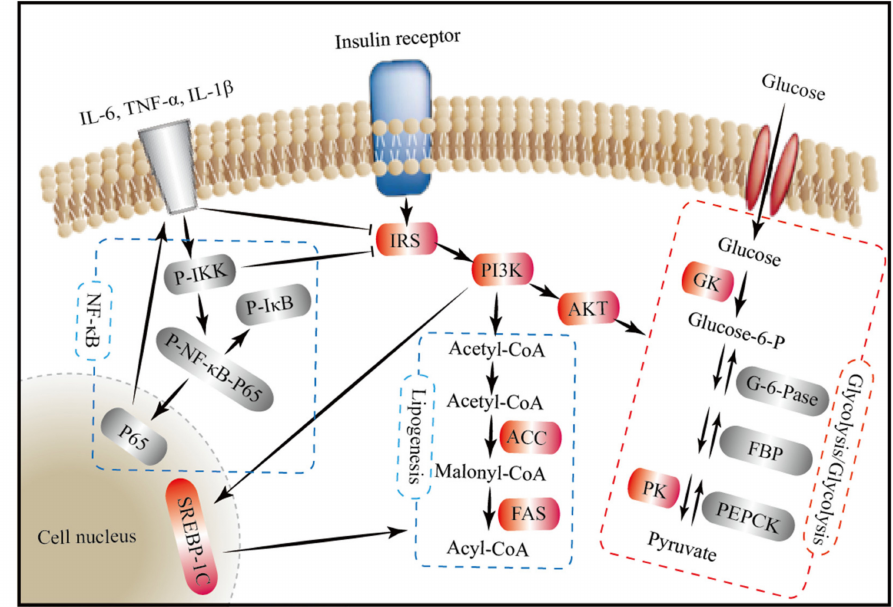
Figure 8. The mechanisms underlying the hypoglycemic effect of foxtail millet from the perspective of signaling pathways. Foxtail millet supplementation might improve the blood glucose metabolism by inhibiting gluconeogenesis, stimulating glycolysis, and repairing fatty acid synthesis through the insulin-mediated PI3K/AKT signaling pathway, as well as reducing inflammation through the NF- κ B signaling pathway. Red background, significantly upregulated genes or proteins; grey background, significantly downregulated genes or proteins; arrow for promotion and —| for inhibition; IRS, insulin receptor substrate; PI3K, phosphatidylinositol-3-kinase; AKT, protein kinase B; GK, glucose kinase; PK, pyruvate kinase; G6P, glucose-6-phosphatase; FBP, fructose bisphosphatase; PEPCK, phosphoenolpyruvate carboxy; FAS, fatty acid synthase; ACC, acetyl-CoA carboxylase; SREBP1c, sterol regulatory element-binding protein-1c; IKB, κ B kinase; IKK, inhibitor of κ B